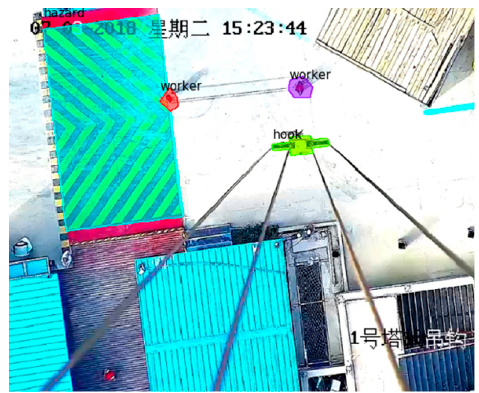
Figure 7. Recognition result of sample image through the Mask R-CNN method.